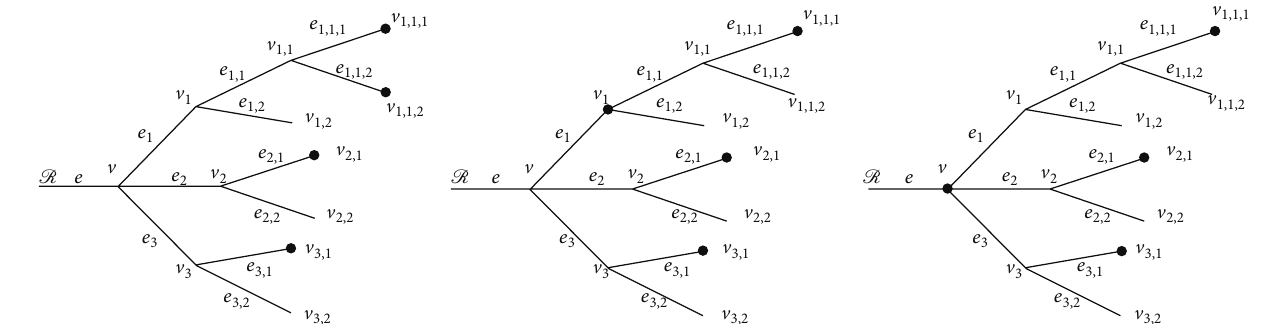
Figure 3: Fewer controllers are needed for the exponential